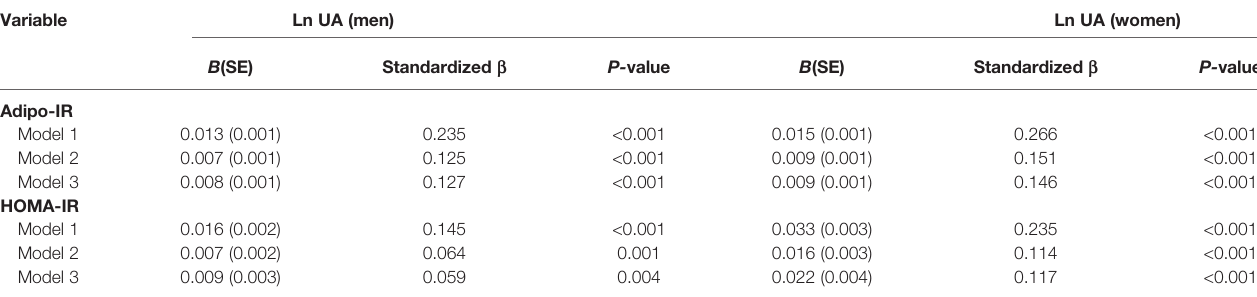
TABLE 2 | Linear regression analysis for association of Adipo-IR and HOMA-IR (independent variables) with LnUA (dependent variable).